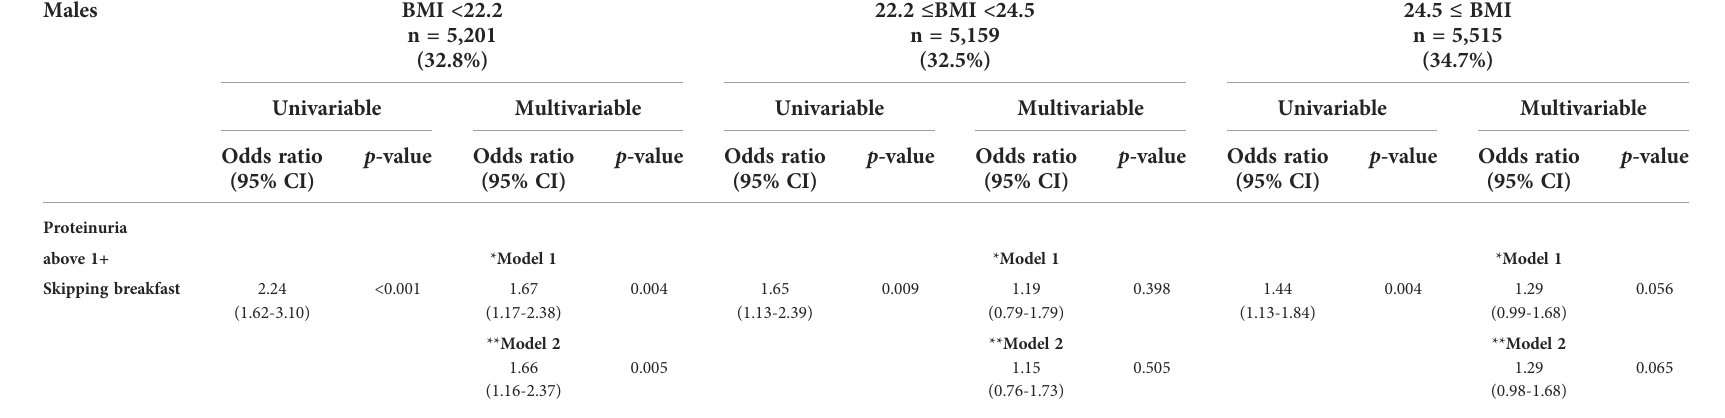
TABLE 3A Logistic regression analysis for the skipping breakfast and the prevalence of proteinuria above1+ in 15,875 males strati fi ed by body mass index (BMI) levels. Males